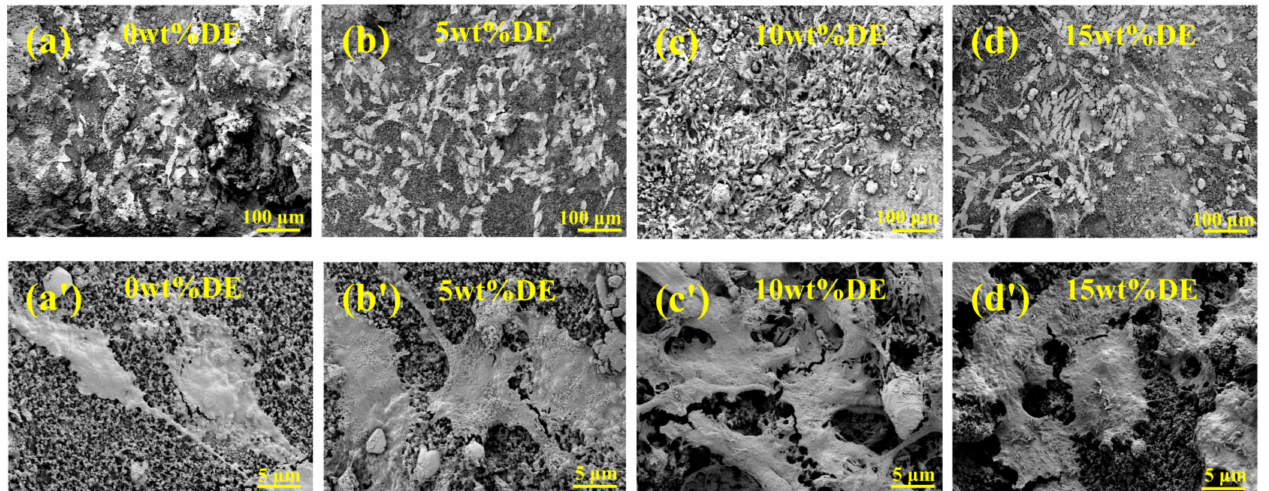
Figure 7. Cell growth morphology of MG63 cells at 3 d on coatings with different contents of DE, ( a , a (cid:48) ) 0wt% DE; ( b , b (cid:48) ) 5wt% DE; ( c , c (cid:48) ) 10wt% DE; ( d , d (cid:48) ) 15wt%